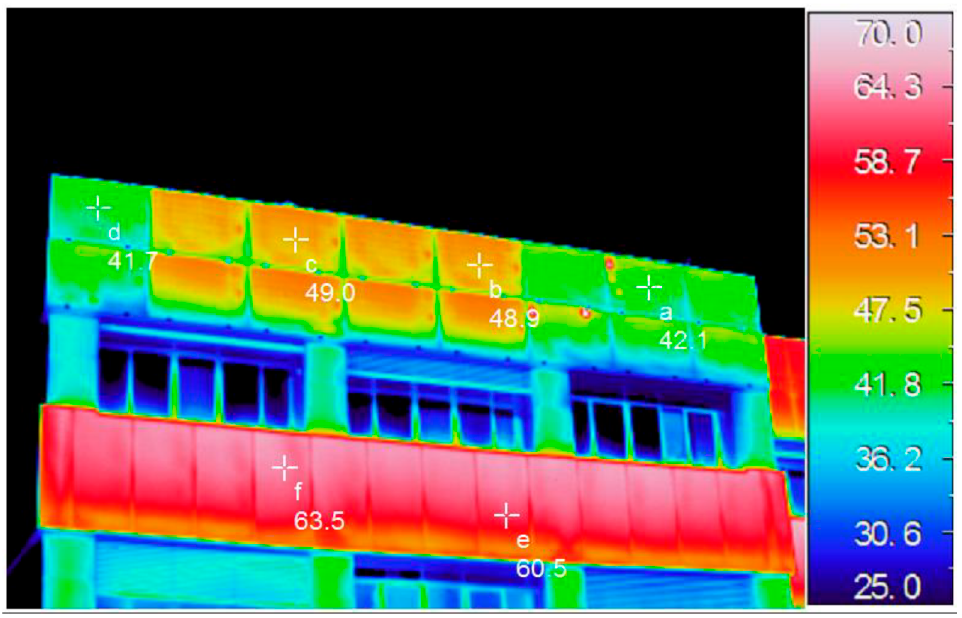
Figure 13. Thermography of part of the west façade, comparing the surface temperatures of the PV modules (upper line) with those of the polymer concrete panels (lower line) [41]. modules (upper line) with those of the polymer concrete panels (lower line)